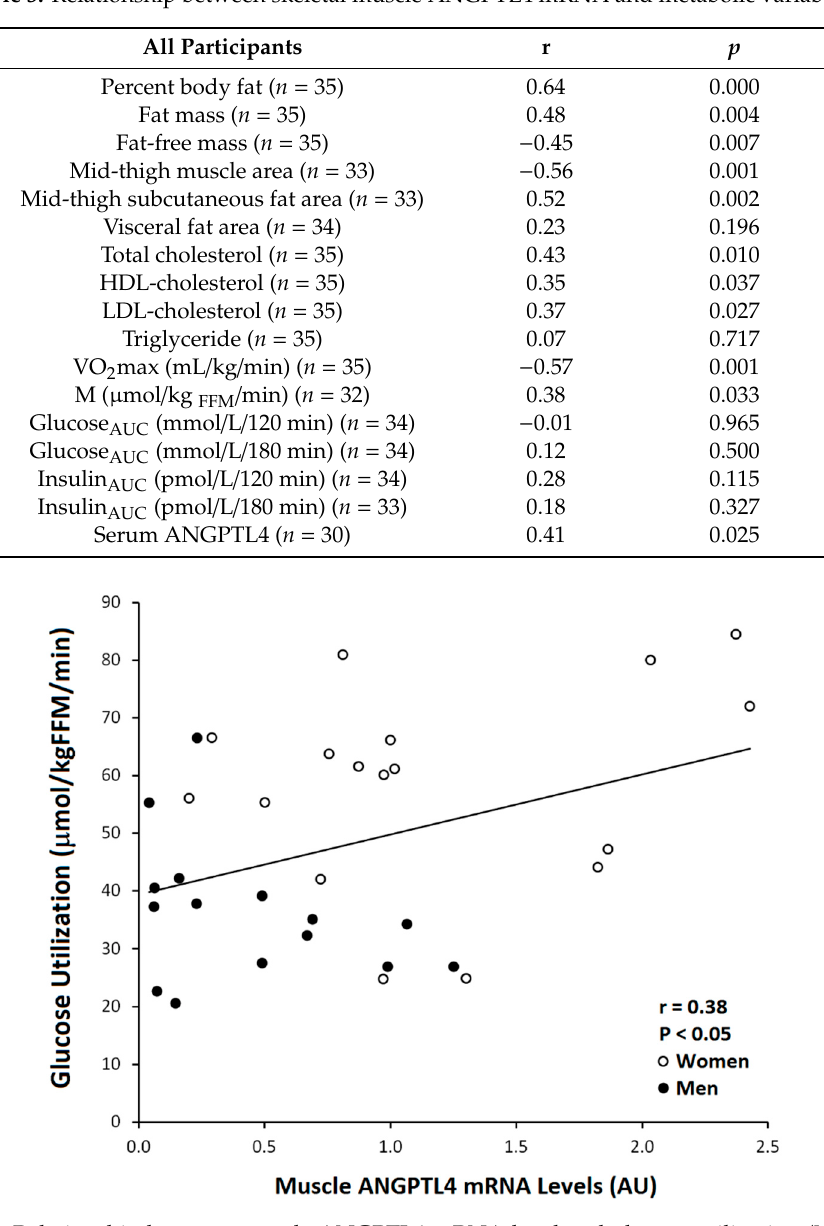
Figure 5. Relationship between muscle ANGPTL4 mRNA level and glucose utilization (M) (Total: n = 32, Women ○ : n = 17, Men ● : n = 15; r = 0.38, p < 0.05) at baseline.